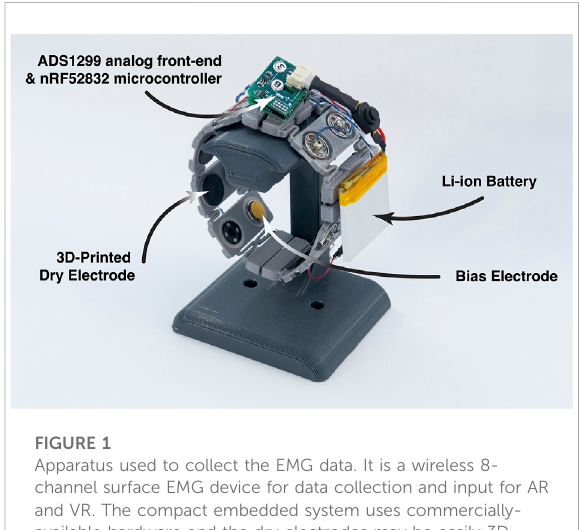
FIGURE 1 Apparatus used to collect the EMG data. It is a wireless 8- channel surface EMG device for data collection and input for AR and VR. The compact embedded system uses commercially- available hardware and the dry electrodes may be easily 3D